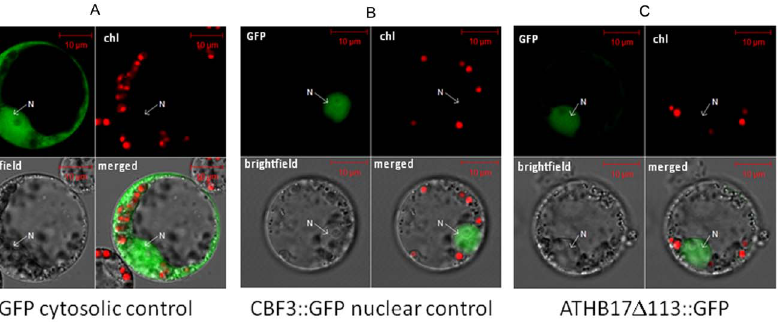
Figure 5. ATHB17 D 113 is localized to nucleus. Fluorescence micrographs of maize leaf protoplasts transformed with (A) GFP alone, (B) AtCBF3 fused to GFP as positive control for nuclear localization or (C) ATHB17 D 113 fused with GFP. Protoplasts from each construct were analyzed by laser scanning microscopy for GFP and chlorophyll fluorescence and acquired images were merged on bright-field image using the Image examiner (See Materials and Methods for details).